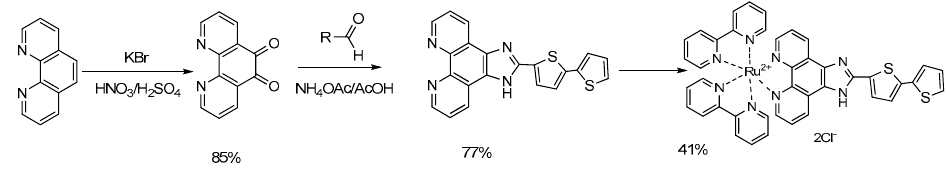
Figure 11. Scheme of the synthesis of Ru-TT complex.